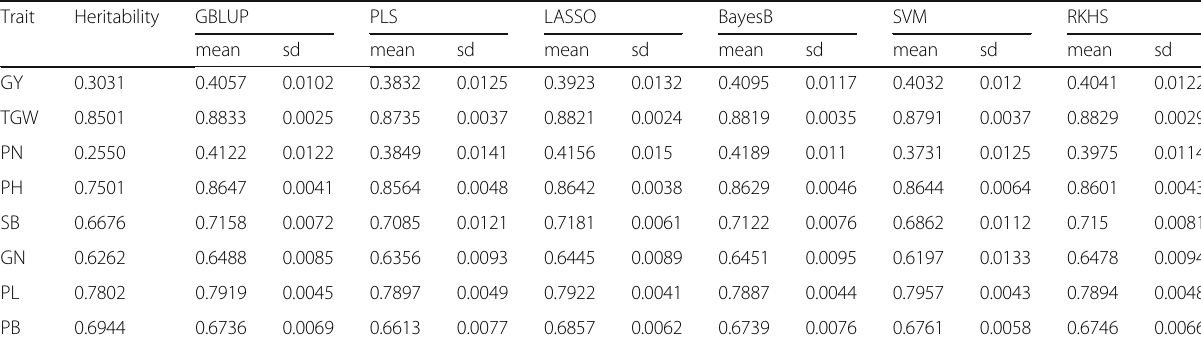
Table 1 Average predictabilities and their standard deviations (sd) for eight traits using six prediction methods Trait Heritability